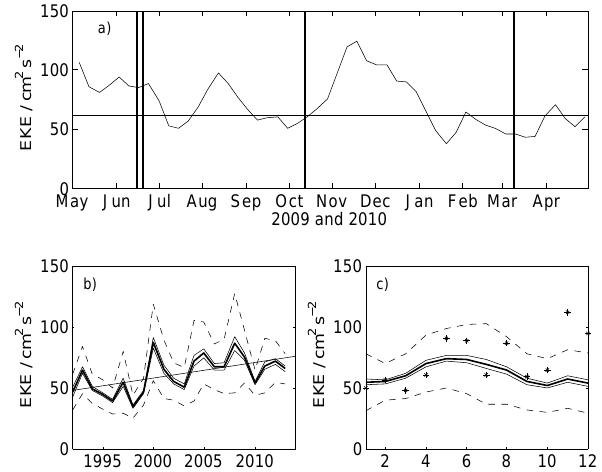
Figure 9. Mean EKE (cm 2 s − 2 ) in the area bounded by 56 ◦ N, 13 ◦ W and 58 ◦ N, 9 ◦ W (see Fig. 1) from altimetry. (a) Weekly EKE from 1 May 2009 to 30 April 2010. Vertical lines mark the times of the Ellett Line section (June 2009) and the start and end of glider Mission 1 (October 2009 and March 2010). (b) Weekly averages binned by year with the annual mean (thick line), bounded by the error in the mean (thin lines) and standard deviation (dashed lines). The straight line is the trend EKE = 1 . 1 × (year number)–2100; (c) as (b) but binned by month and without a trend line. Asterisks show the monthly averages between May 2009 and May